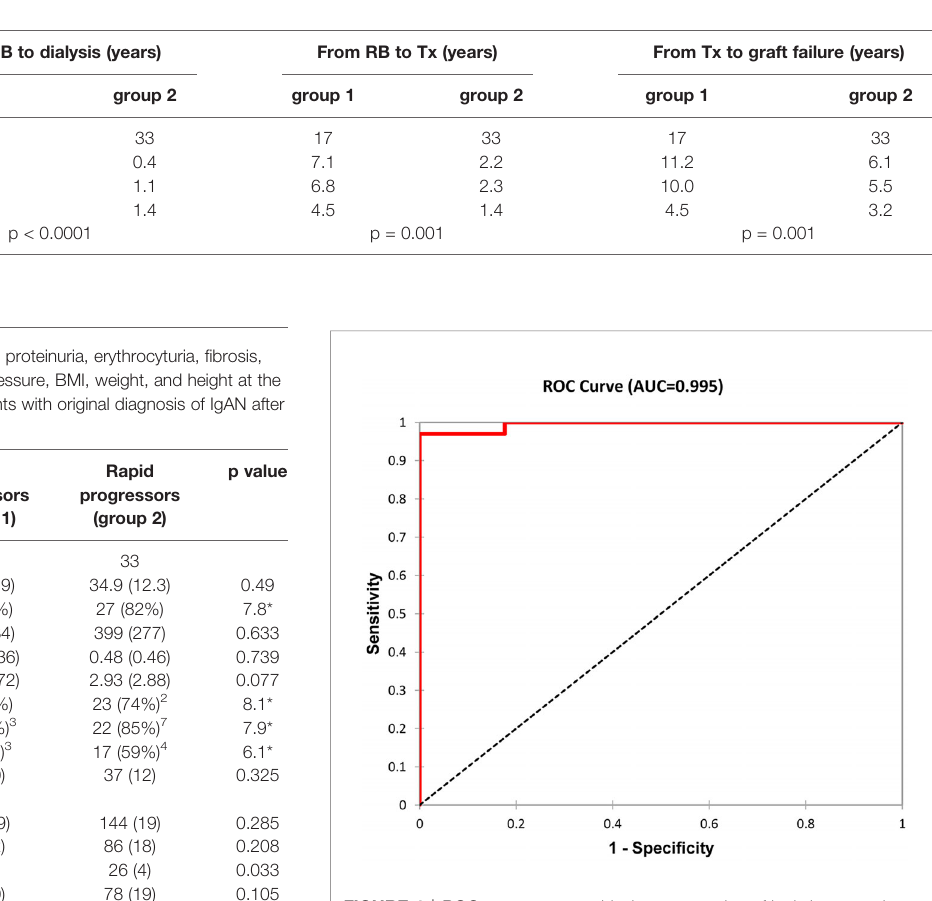
FIGURE 4 | ROC curve as a graphical representation of logistic regression. Patients were distributed according to the time from kidney transplant to graft failure and the time from renal biopsy to end-stage renal disease into two groups (see Table 3 ). A total of 50 patients with graft failure were divided into two groups with 17 and 33 members. Classi fi cation accuracy was